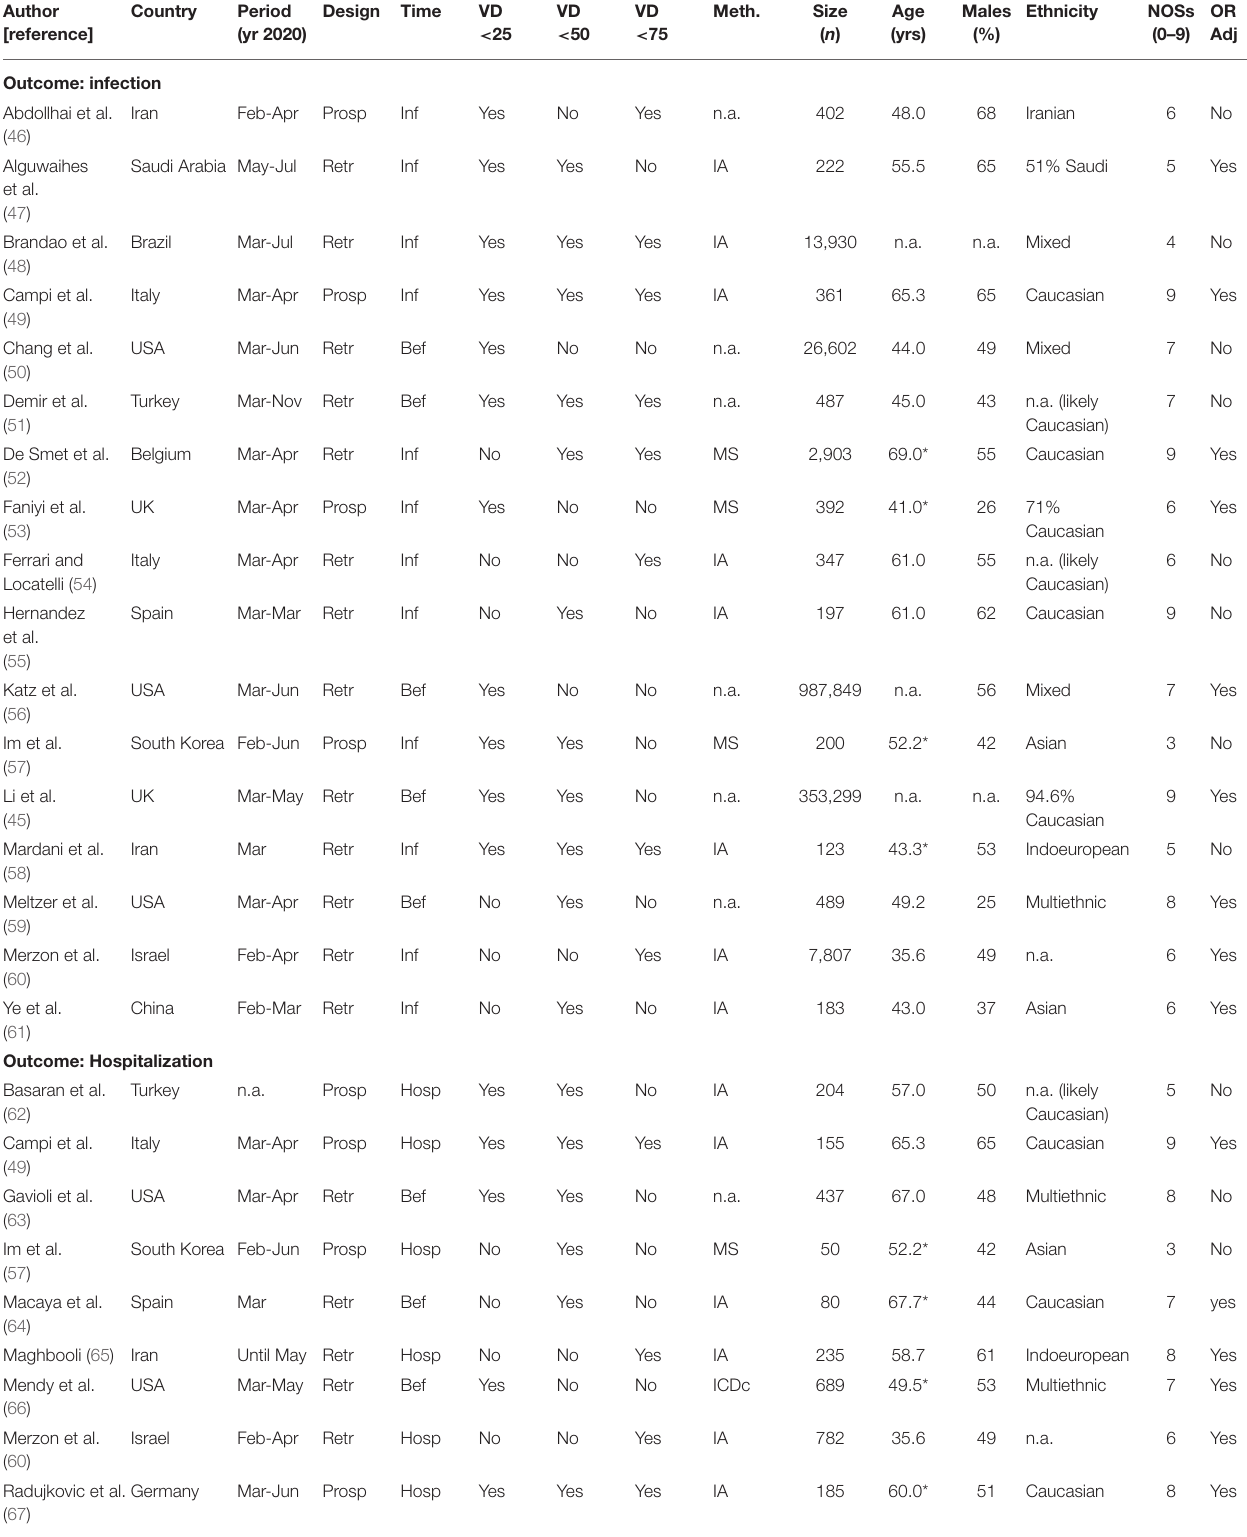
TABLE 1 | Summary of characteristics and quality evaluation by Newcastle Ottawa Scale score (NOSs) of the studies included in the